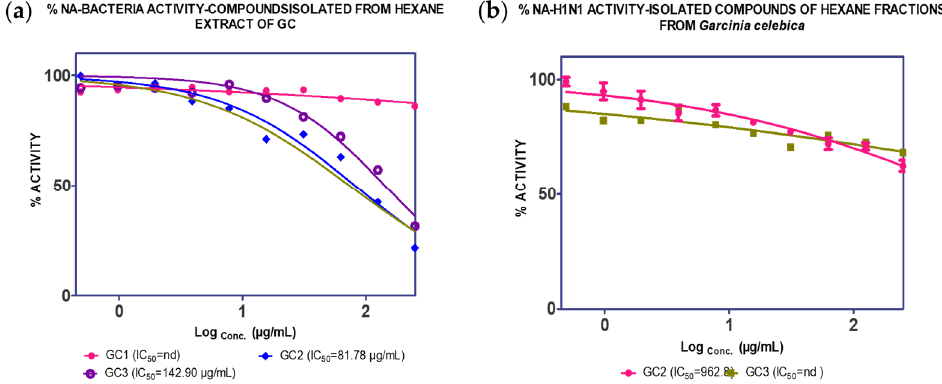
Figure 3. Inhibition activity of isolated compounds from n -hexane fraction of GCL against ( a ) C. perfringens –NA and ( b ) H 1 N 1 -NA.